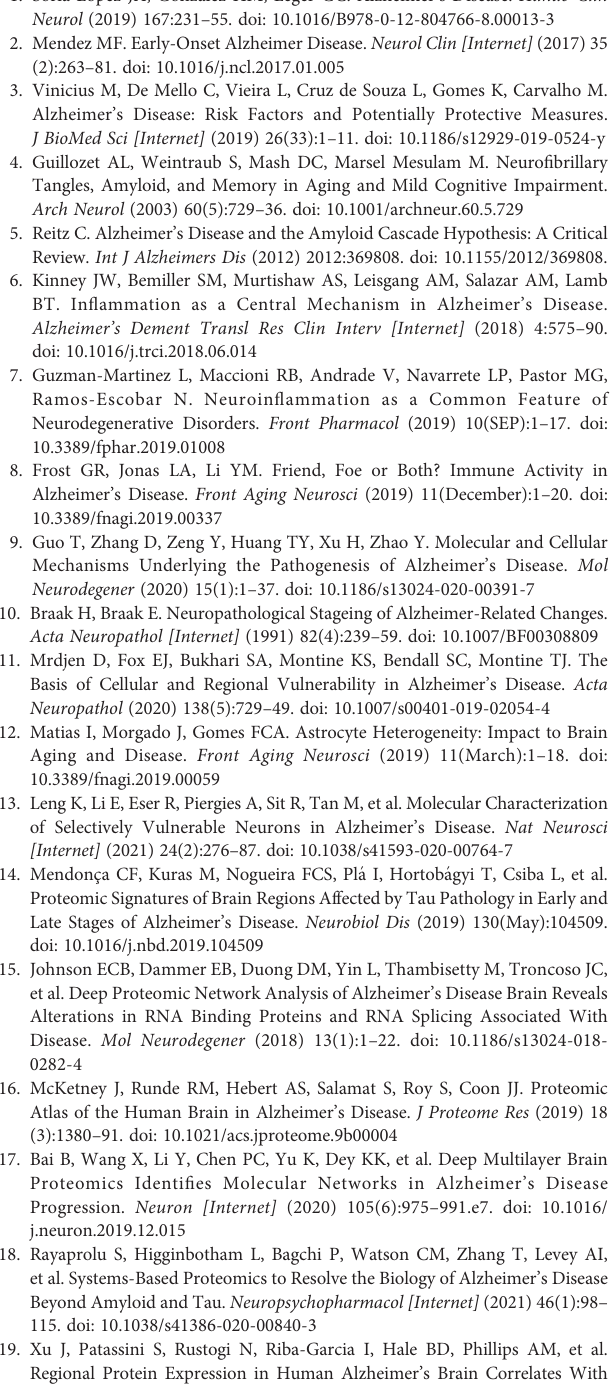
Supplementary Table 5 | Summary of the phosphorylation status analysis. Supplementary Table 6 | Summary of the acetylome analysis. Supplementary Table 7 | Comparison of the four vulnerable AD brain